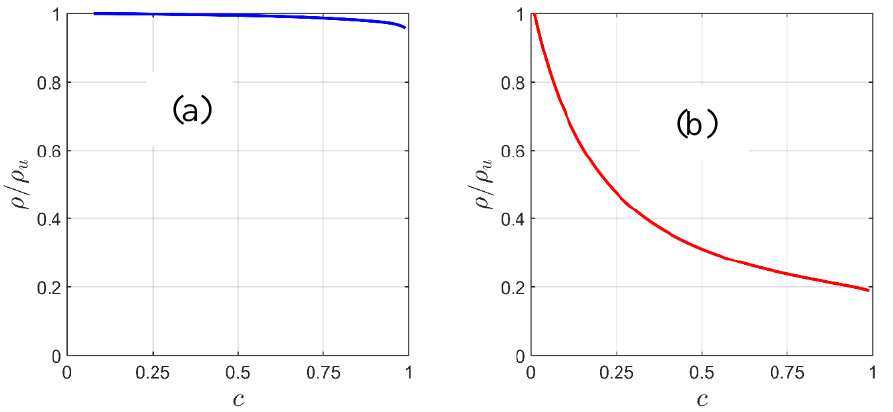
Figure 9. Profiles of the mean values of gas density ρ / ρ u conditioned upon c for CH 4 mass fraction-based reaction progress variable c for ( a ) MILD combustion, ( b ) premixed combustion cases considered here. The unburned gas density is given by ρ u .